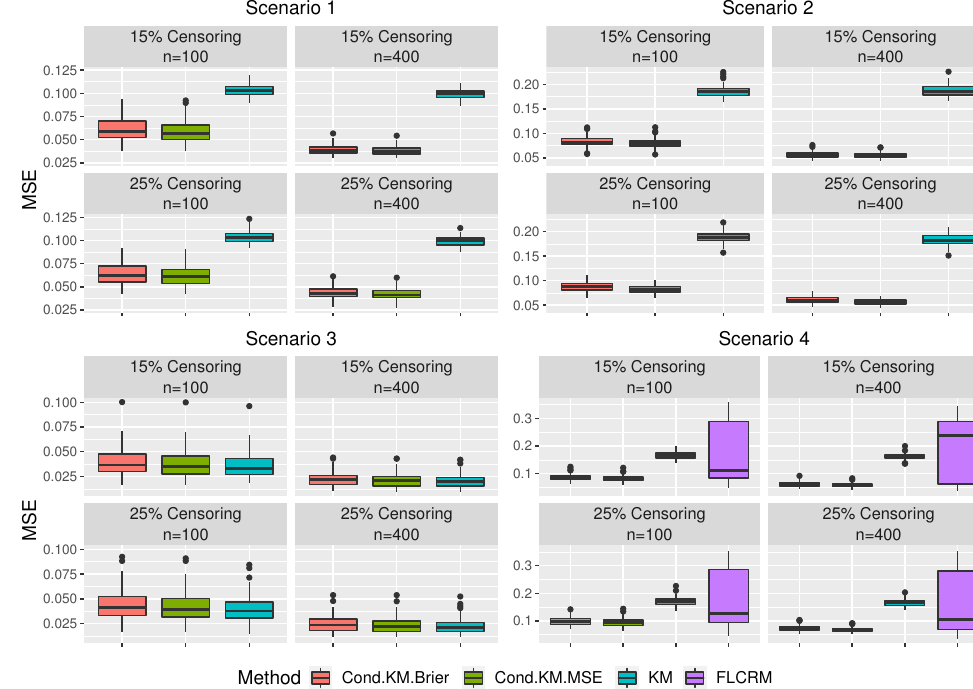
Figure 2. The boxplots represent the sampling distribution of the MSPE based on the 100 simu- lation testing sets. Cond.KM.Brier = Conditional Kaplan–Meier (Bandwidth selection based on Brier scores), Cond.KM.MSE = Conditional Kaplan–Meier (Bandwidth selection based on MSE), KM = Kaplan–Meier and FLCRM = Functional Linear Cox Regression